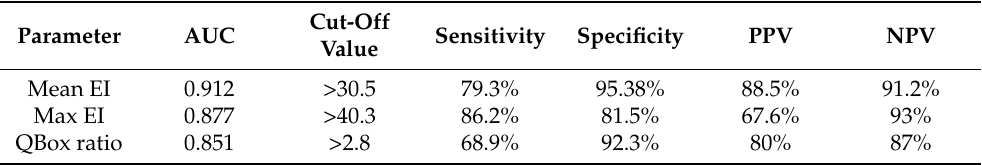
Table 4. The diagnostic performance of 2D-SWE parameters (Mean, Max and QBox ratio) for the presence of thyroid malignancy, using the pathology report as reference.